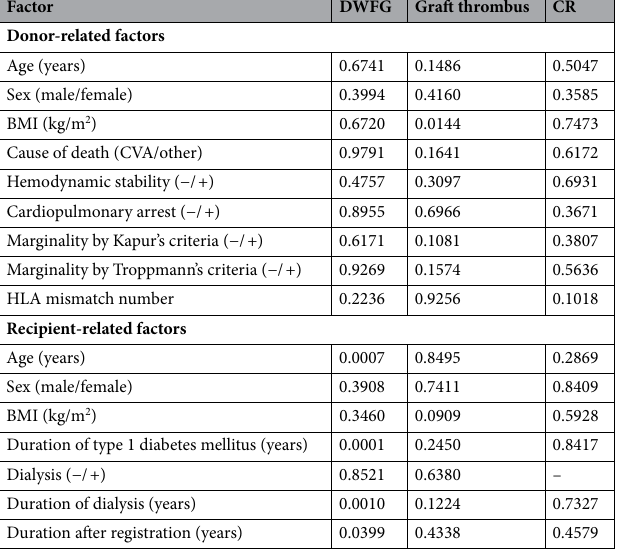
Table 4. Cox proportional hazards regression p-values from univariate analyses of preoperative factors potentially influencing pancreas graft loss after PTx according to specific cause. BMI body mass index, CR